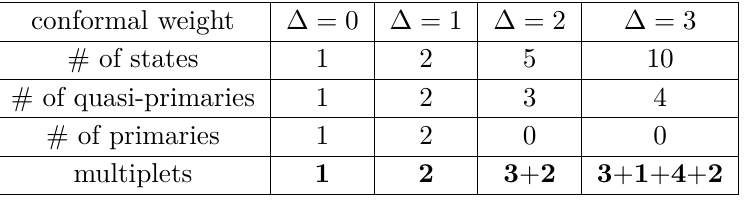
Table 2 . States up to ∆ = 3